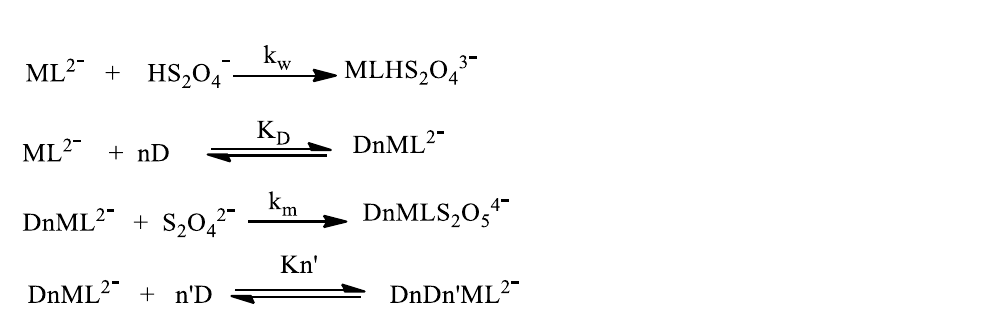
Scheme 1. The micelle—substrate model of Piszkiewicz’s approach.